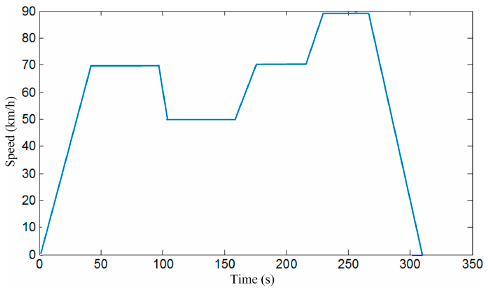
Figure 9. Driving cycle of a city bus in Changchun.